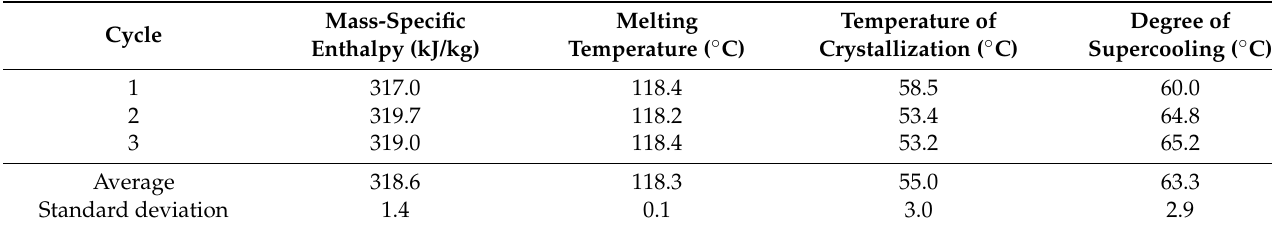
Table 3. Erythritol properties measured by DSC.